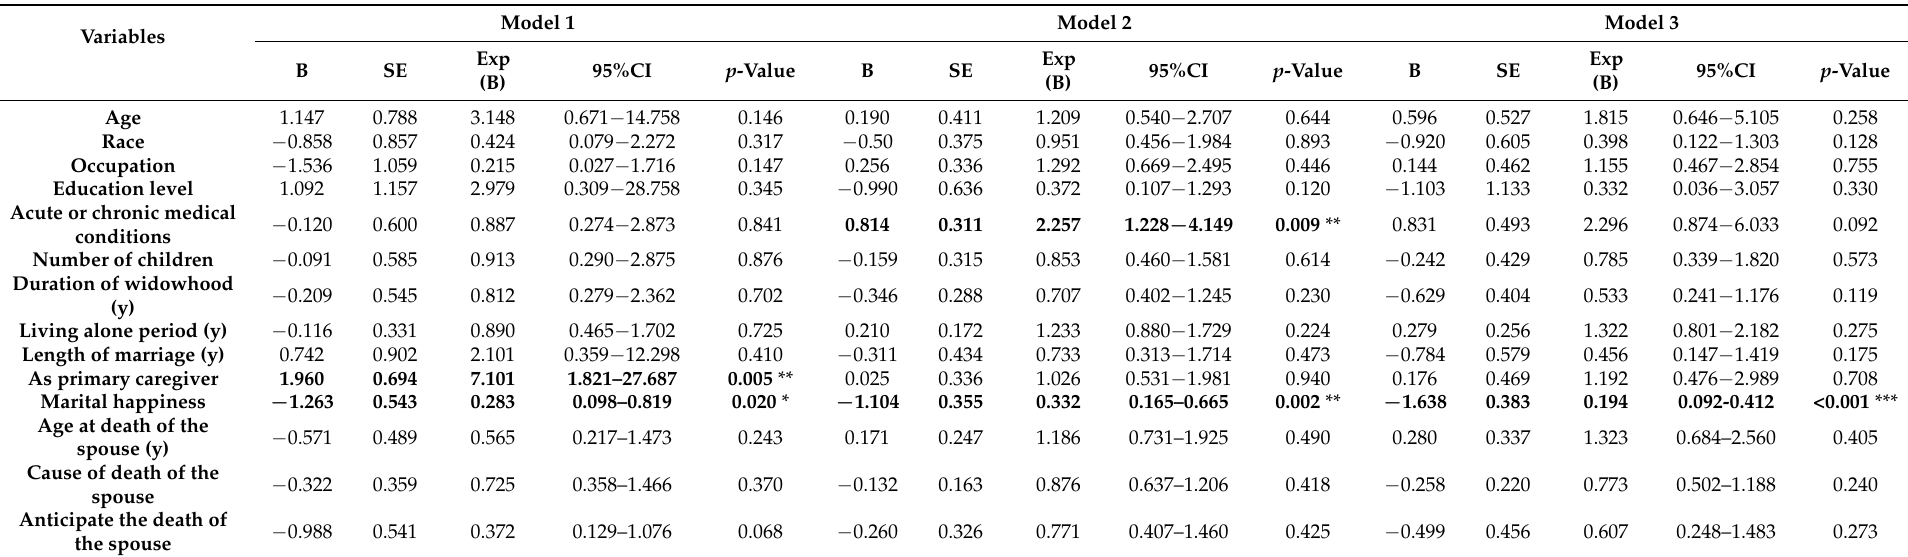
Table 4. Binary logistic regression analysis of loneliness, depression, and anxiety (N =